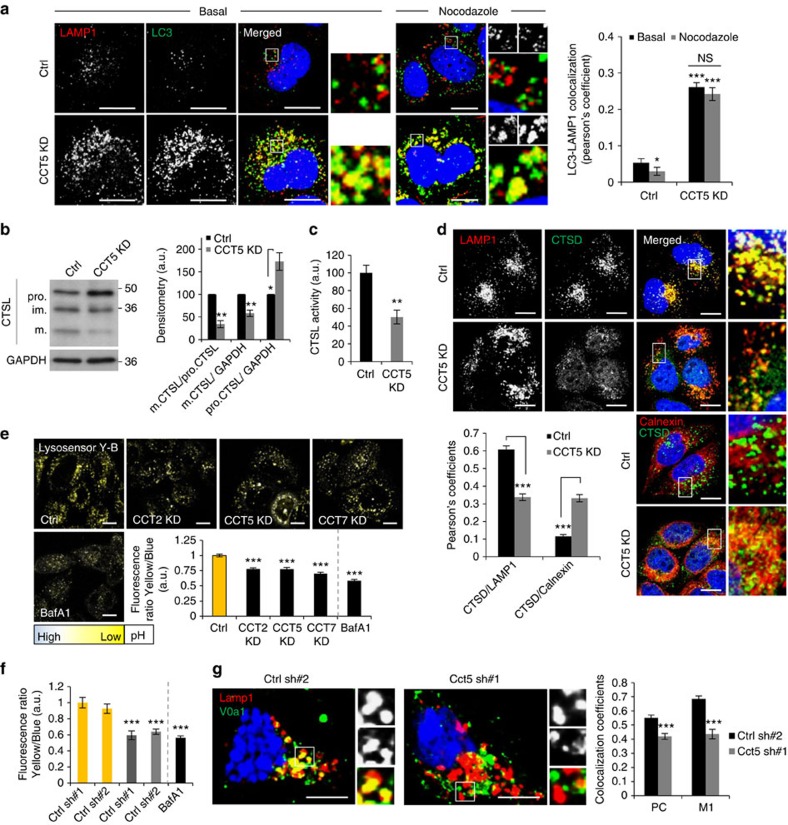
CCT is required for lysosomal functioning and autophagosomes degradation.(a) LC3 (anti-mouse Alexa 488) and LAMP1 (anti-rabbit Alexa 568) colocalization in HeLa cells depleted for CCT5. Right panel: quantification of colocalization (Pearson's coefficient). More than 30 cells were counted per condition. Bars—means±s.e.m. (***P<0.001, *P<0.05, NS, not significant; two-tailed t-test). Similar results were achieved in at least two independent experiments. Scale bar, 10 μm. (b) Immunoblot showing Cathepsin L (CTSL) maturation in CCT5 knockdown HeLa cells. Graph showing the quantification of mature/precursor CTSL ratio is on right as mean±s.d. (n=3; **P<0.01, *P<0.05; two-tailed one sample t-test). (c) Cathepsin L activity in HeLa cells depleted for CCT5. Fluorescence intensity was expressed as percentage of control. Bars—mean±s.d. (n=3; **P<0.01; two-tailed t-test). (d) Cathepsin D (CTSD, anti-mouse Alexa 488)—LAMP1 (anti-rabbit Alexa 568) and cathepsin D (anti-mouse Alexa 488) —calnexin (anti-rabbit Alexa 568) double-immunostaining in CCT5-knockdown cells. More than 40 cells were quantified per experiment (each experiment was performed at least twice with similar results). Bars—mean of Pearson's coefficient±s.e.m. (***P<0.001; two-tailed t-test). Scale bar—10 μm. See also Supplementary Fig. 6e. (e) Lysosomal pH in CCT-depleted cells. The Lysosensor Yellow Blue intensity was measured in both yellow and blue channels. Intensities ratio is a qualitative measure of lysosomal pH. Bafilomycin A1 (Baf A1) was used as a positive control (400 nM, 3 h) for increased lysosomal pH >50 cells were analysed per experiment, for each condition. Experiment was performed at least 3 times with similar results. Bars—mean±s.e.m. (***P<0.001; two-tailed t-test). (f) Lysosomal pH in Cct5-depleted mouse primary cortical neurons. Lysosensor Yellow Blue intensity was measured as in e. Bafilomycin A1 was used as a positive control (400 nM, 6 h) for increased lysosomal pH >40 neurons were analysed per experiment and per condition. Experiment was performed at least three times with similar results. Bars—means±s.e.m. (***P<0.001; two-tailed t-test). See also Supplementary Fig. 6f. (g) Voa1 (anti-rabbit Alexa555) and Lamp1 (anti-rat Alexa647) double-immunostaining in mouse primary cortical neurons. Neurons were plated and treated as in f. More than 30 neurons were counted per condition. PC is Pearson's coefficient; M1 is Mander's coefficient 1, which indicates the Voa1 localization in the Lamp1 compartment. Bars—means±s.e.m. (***P<0.001; two-tailed t-test). Scale bar—10 μm. See also Supplementary Fig. 6g.